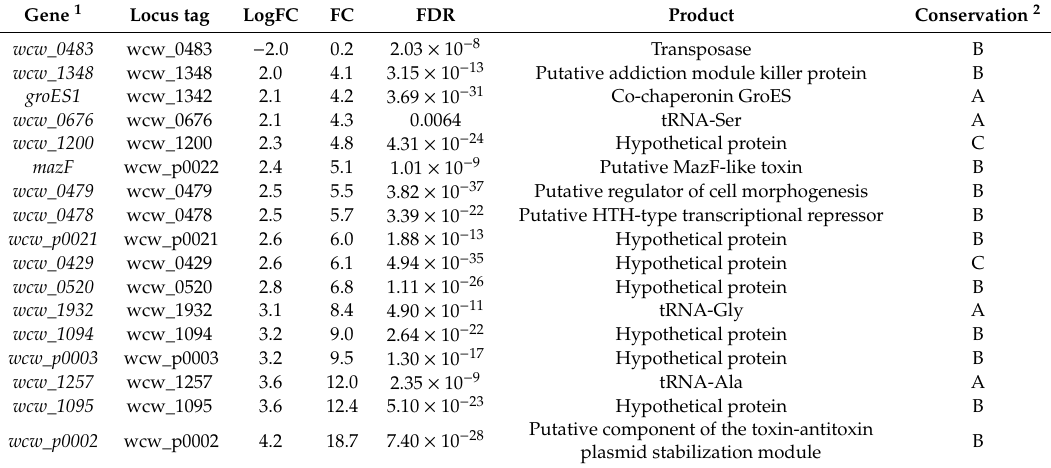
Figure 5. The most down- or up-regulated genes in persistent W. chondrophila . Volcano plot displaying the di ff erential gene expression of persistent versus untreated W. chondrophila . Each point represents the average value of one gene from two (BPDL-treated) or three (untreated) replicates. Colored points represent the most significantly di ff erentially expressed genes, with an FDR ≤ 0.01 (False Discovery Rate) and a log2FC ≤ − 2 (blue) or ≥ 2 (red). If available, the gene name is indicated. Table 1. Summary of the genes showing the highest change in expression upon